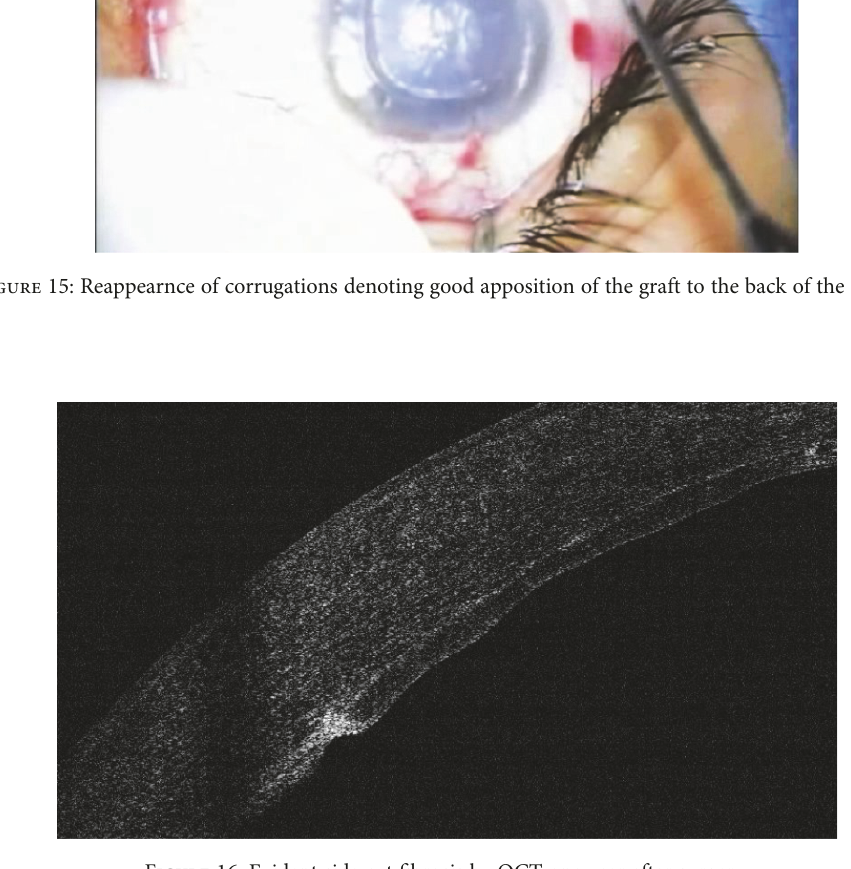
Figure 16: Evident side cut fi brosis by OCT one year after